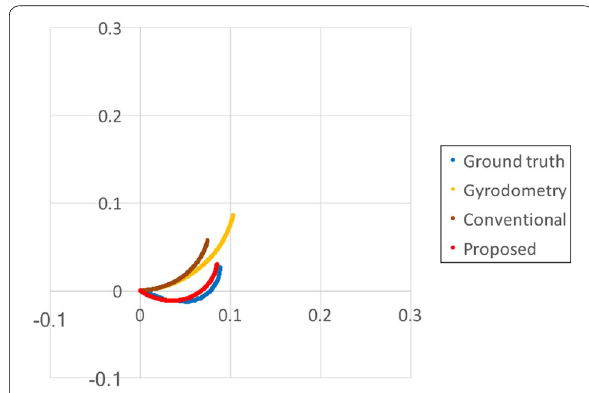
Fig. 18 Result of position estimation: slope angle is 15 ◦ , input veloc- ity is 5 cm/s, and input angular velocity is 30 ◦ /s